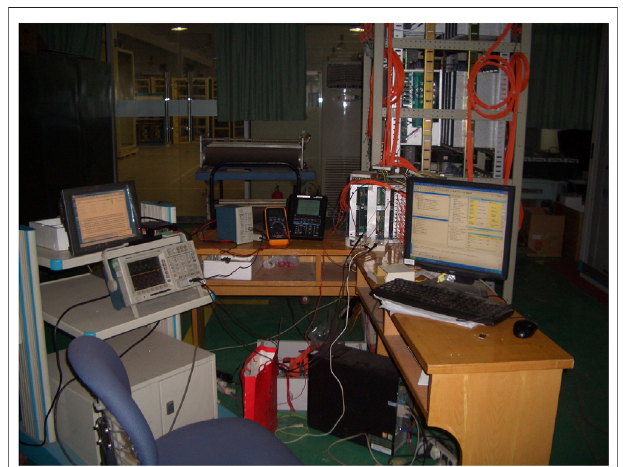
FIGURE 12 | Laboratorial 2 kV/100 kVar CMC-based STATCOM platform.